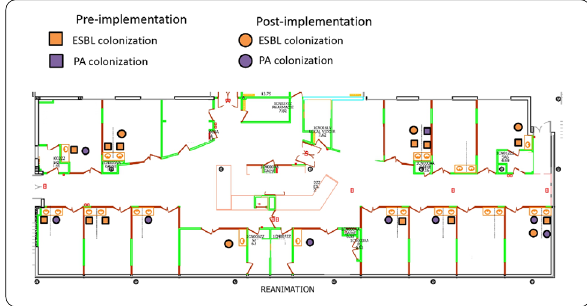
Figure. ICU maps FC‑192 Echocardiography in the Time of